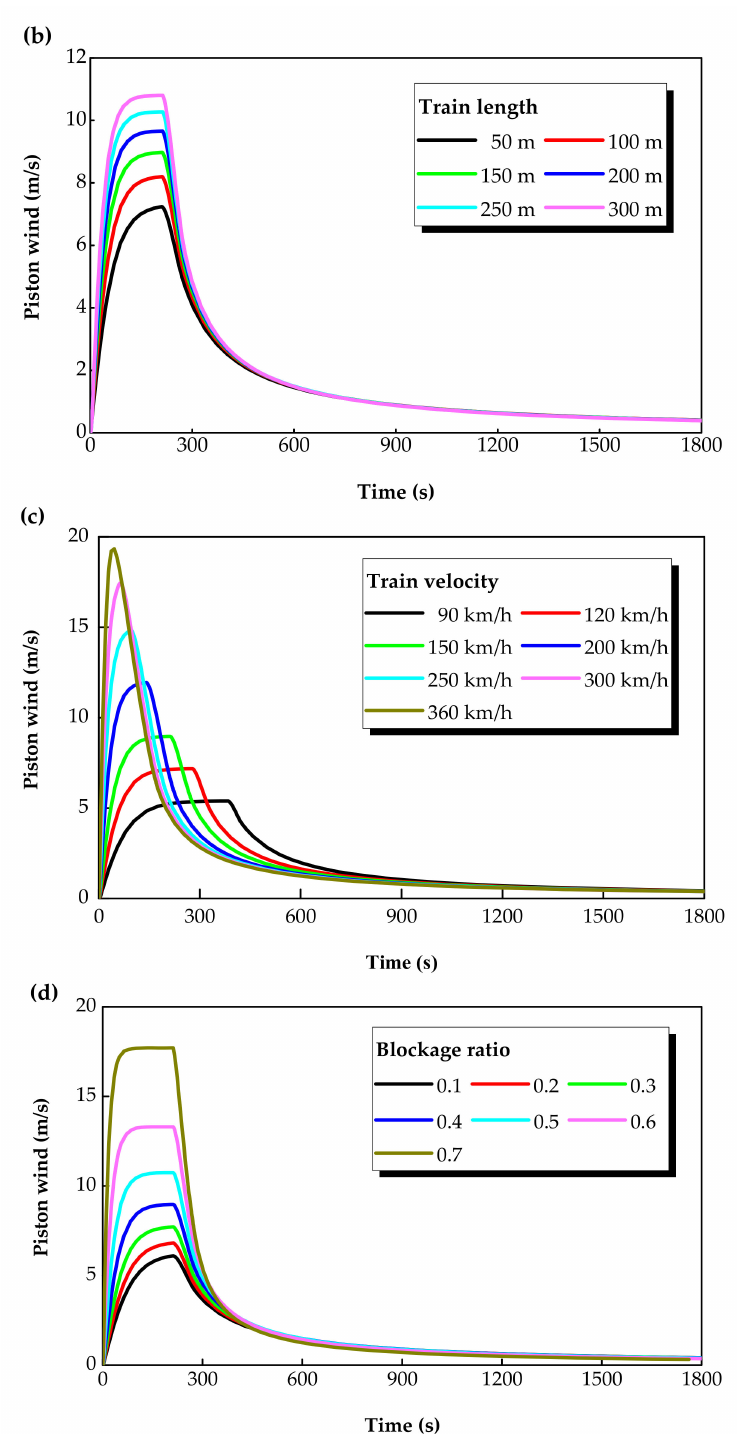
Figure 9. The e ff ect of di ff erent parameters on piston wind behavior induced by a train emergently running to a rescue station. ( a ) Tunnel length. ( b ) Train length. ( c ) Train velocity. ( d ) Blockage ratio. (1)